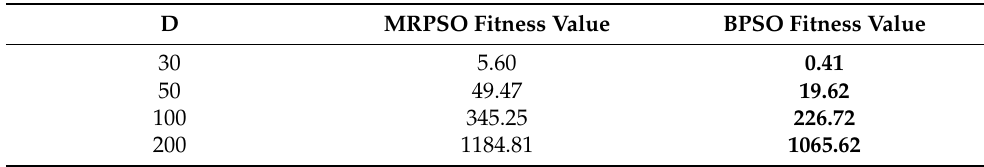
Table 14. Mean of the particle best-fit values in MRPSO and BPSO on f 1 . The bold numbers refers to the better results.